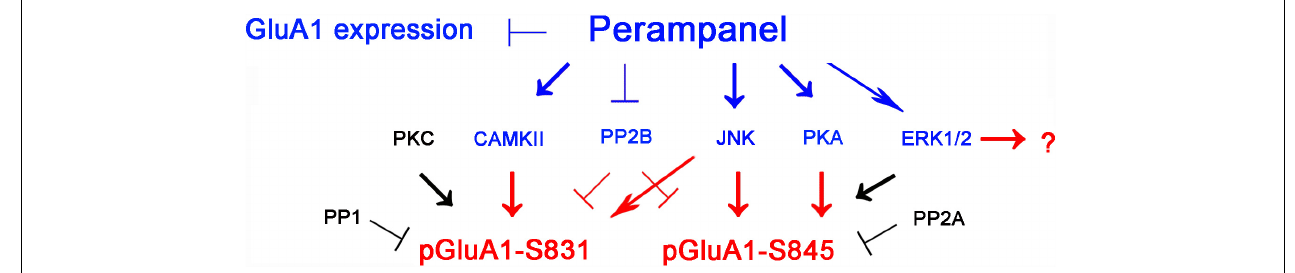
FIGURE 13 | Summary of the effects of perampanel on GluA1 phosphorylations in epileptic rats. Perampanel reduces GluA1 expression. In addition, perampanel increases CAMKII, JNK, PKA, PP2B, and ERK1/2 phosphorylations (blue), which regulate GluA1 phosphorylation (red) except ERK1/2. Perampanel does not affect PKC, PP1, and PP2A phosphorylations (black), which are reported to modulate GluA1